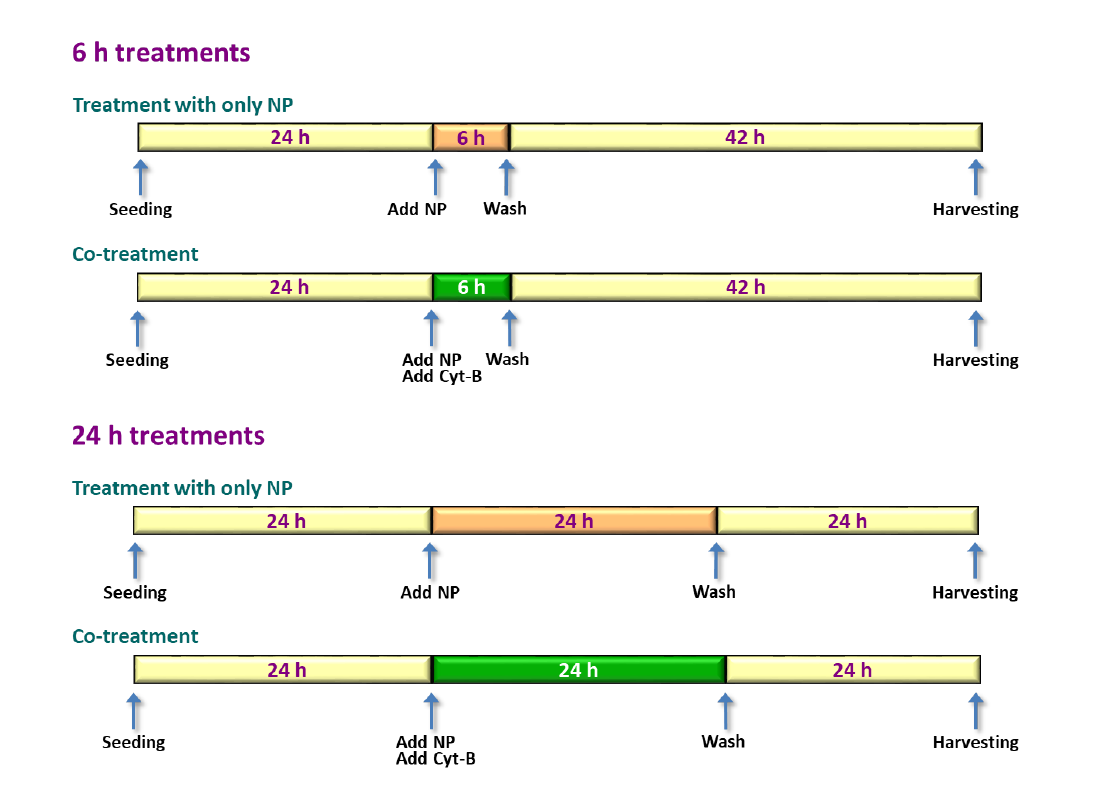
Figure 2. Scheme showing the chronology of FCMN test experiments. Exposure of the cells to TiO 2 NP was conducted for 6 and 24 h both in the presence and in the absence of Cyt-B. Color code: yellow: no treatment; orange: treatment with NP; green: treatment with NP + Cyt-B.